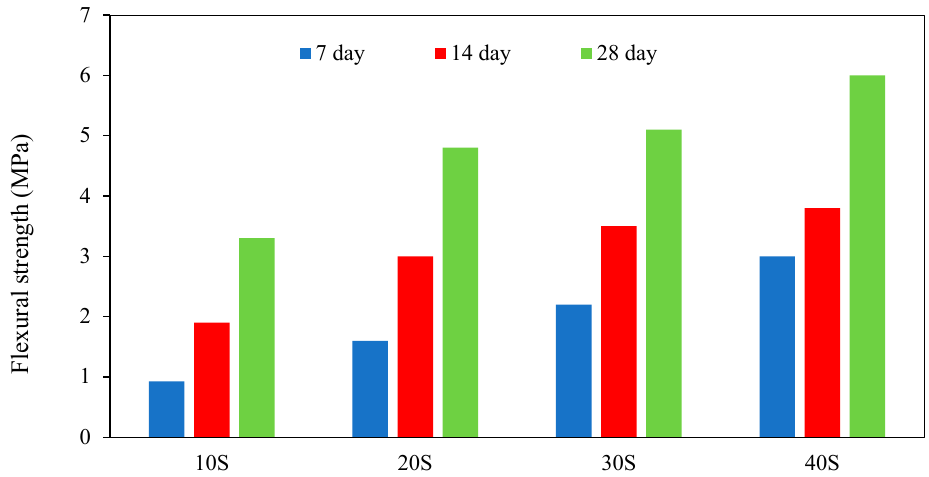
Figure 11. Influence of GGBFS volume on the ultimate flexural strength of GPM [54]. According to Erfanimanesh et al. [45], flexural strength comparison between GPM and PC mortar (Na 2 CO 3 concentration was about 10% by weight of powder mixes (zeolite and slag), and 100% Fine Aggregate). GPM’s flexural strength was tested using two distinct mix designs that used slag and zeolite as base ingredients. As shown in Figure 12, the geopolymer and the PC mortars had nearly comparable flexural strengths.